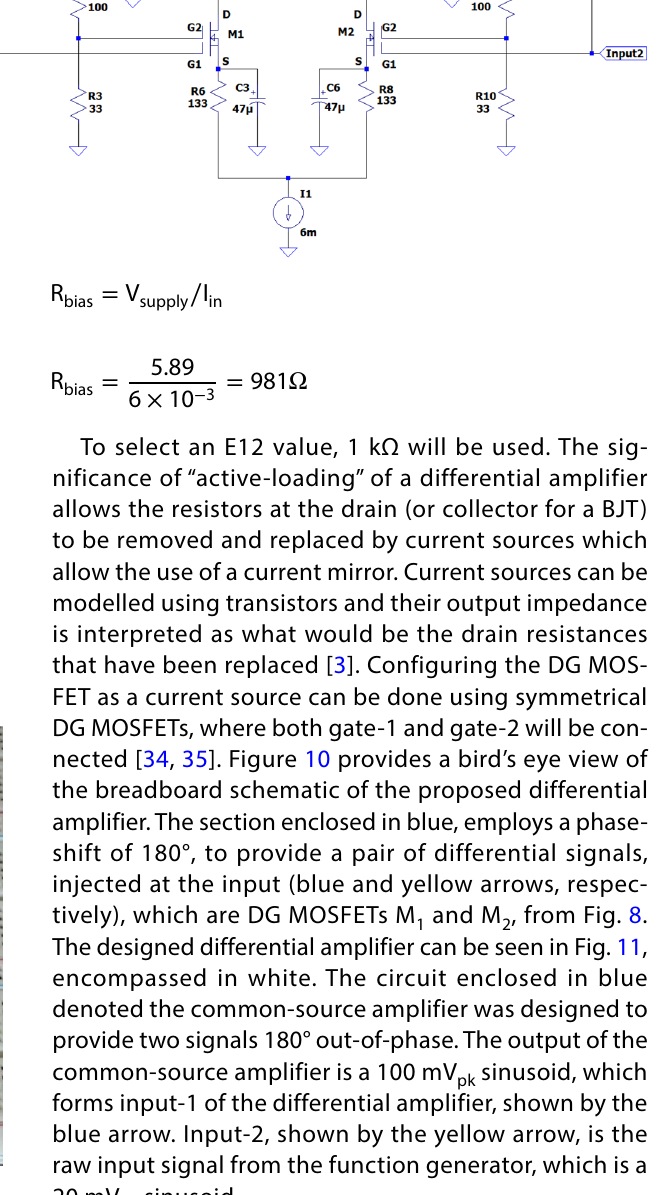
Fig. 10 The circuit arrangement of the active-loaded differential